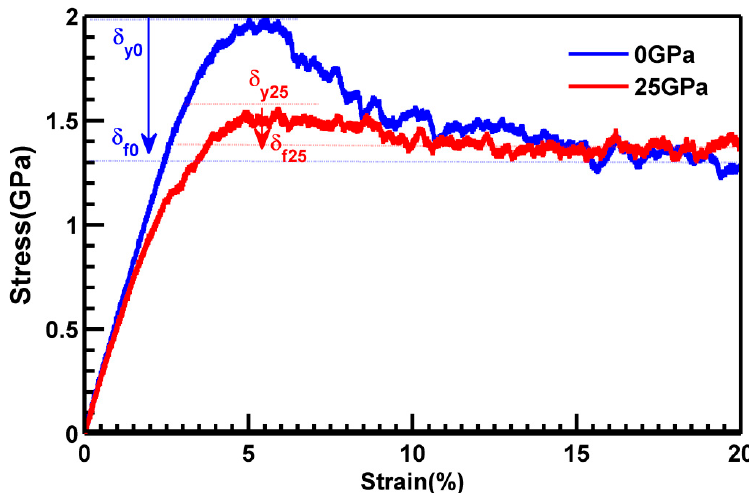
Figure 6. The stress-strain curve obtained from compression testing of samples quenched under 0 GPa and 25 GPa.